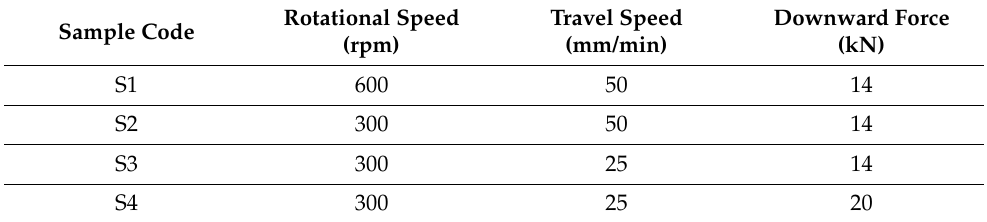
Figure 1. ( a , b ) front photos illustrate the FSW facilities and fixture system to weld 2205 DSS but joins. ( c ) back photo shows starting the welding process and direction. Table 2. FSW Parameters that were used to Weld the 2205 DSS Butt